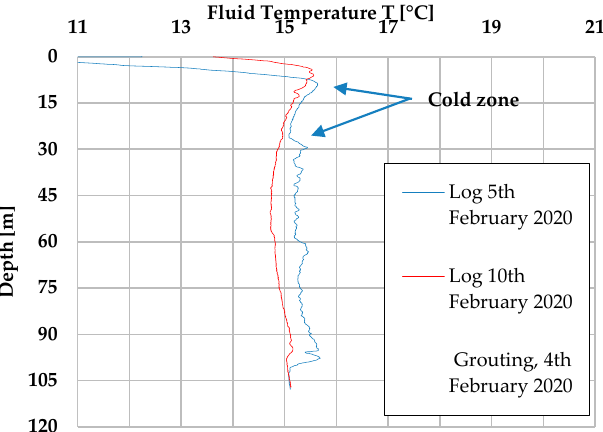
Figure 6. Vertical ground temperature profiles at the PIS pilot BHE during the grout hydration period (18 September profile) as compared to the one at the end of the chemical reaction. A “cold zone” appears at both periods.